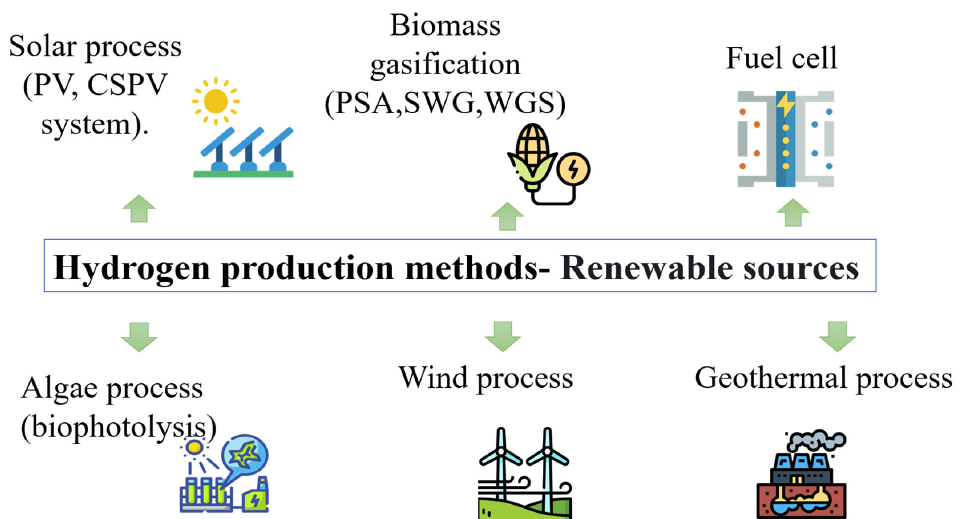
Figure 11. Hydrogen Production through Renewable Energies.